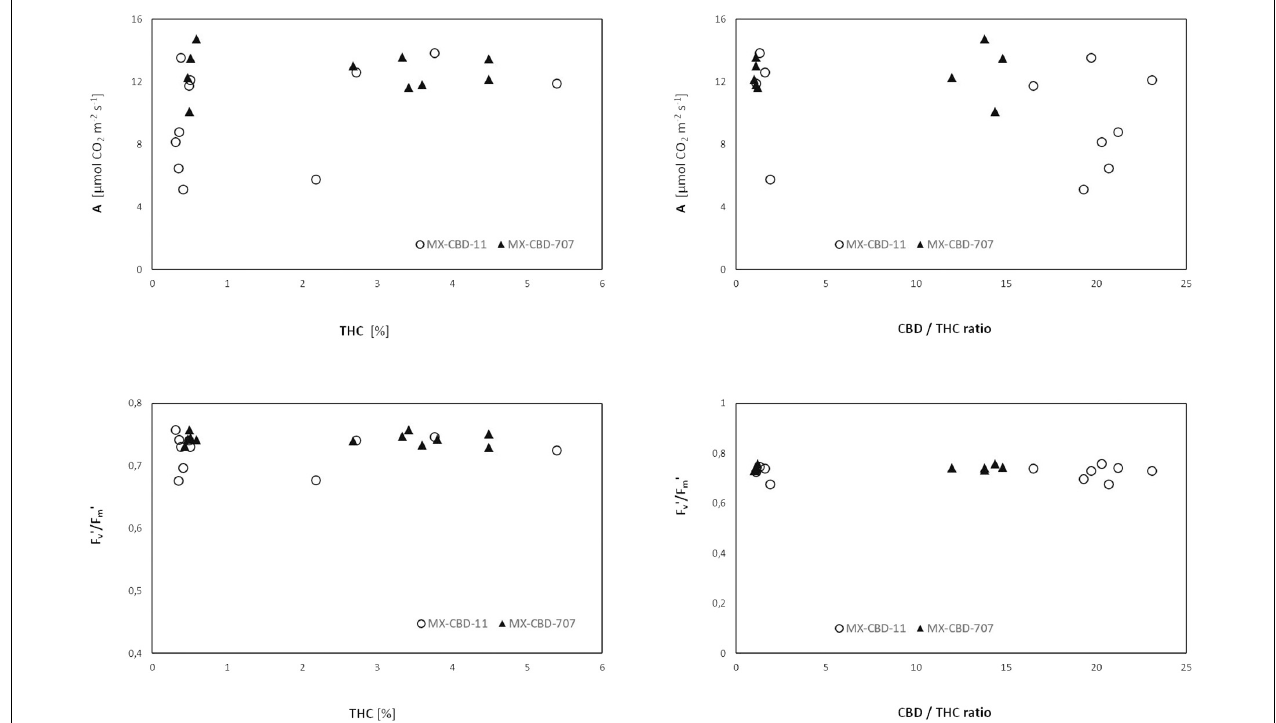
FIGURE 7 | Net photosynthesis ( A ) and photochemical efficiency F v (cid:48) / F m (cid:48) of two breeding populations of medical cannabis MX-CBD-11 and MX-CBD-707 as a function of cannabinoid content.